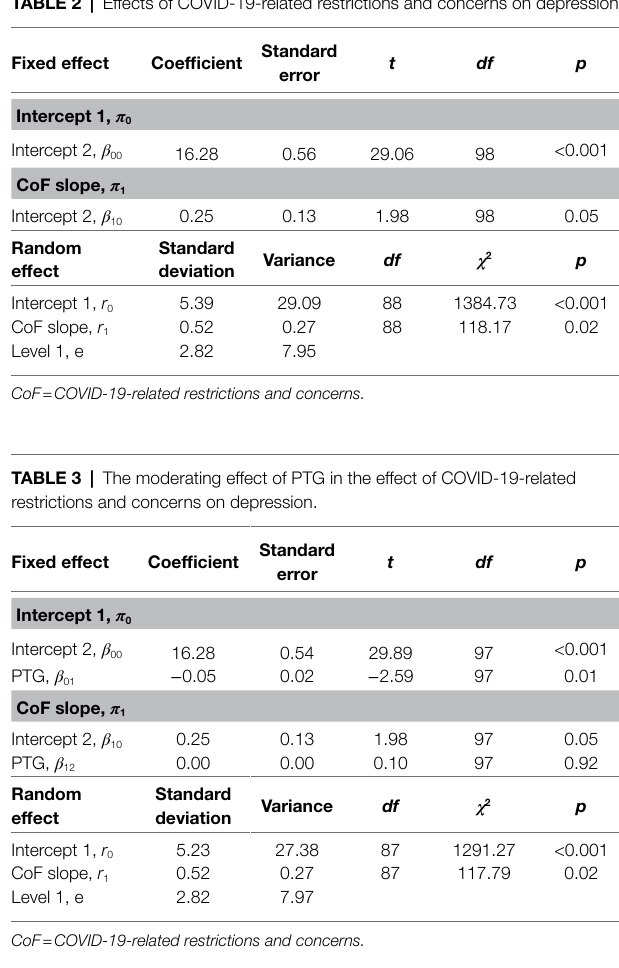
TABLE 4 | Effects of COVID-19-related restrictions and concerns on anxiety. TABLE 2 | Effects of COVID-19-related restrictions and concerns on